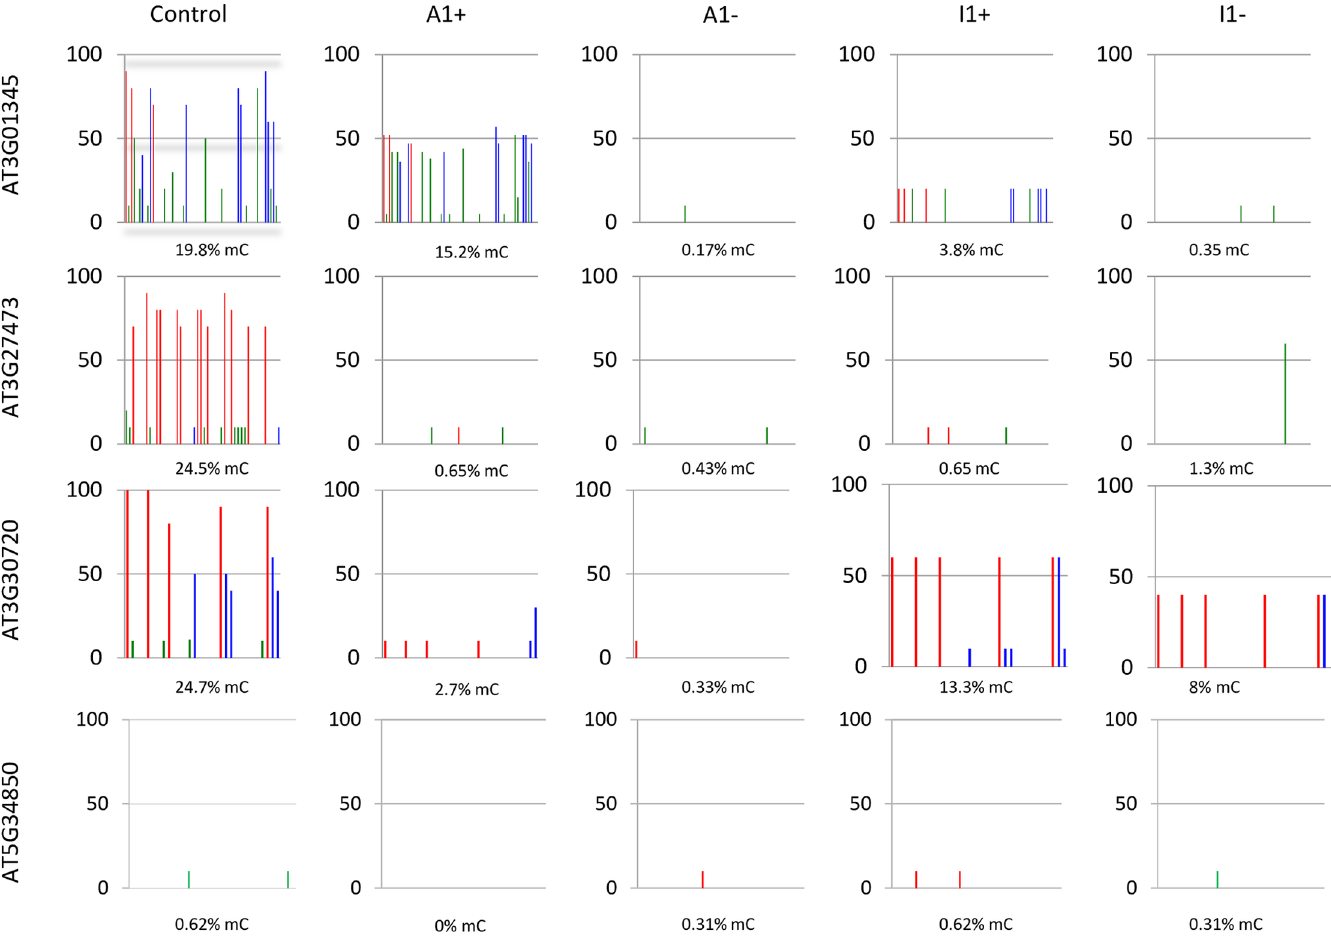
Fig 3. DNA methylation analysis of regions (S3 Fig) of genes AT3G01345 , AT3G27473 , AT3G30720 , AT5G34850 in MET1 transformants (+) and in lines derived from MET1 transformants, from which the transgene has been removed (-). Lines A expresses a catalytically active MET1 transgene, line I1 expresses a catalytically inactive MET transgene. Red bars denote CG methylation, blue bars CHG methylation and green bars CHH methylation.